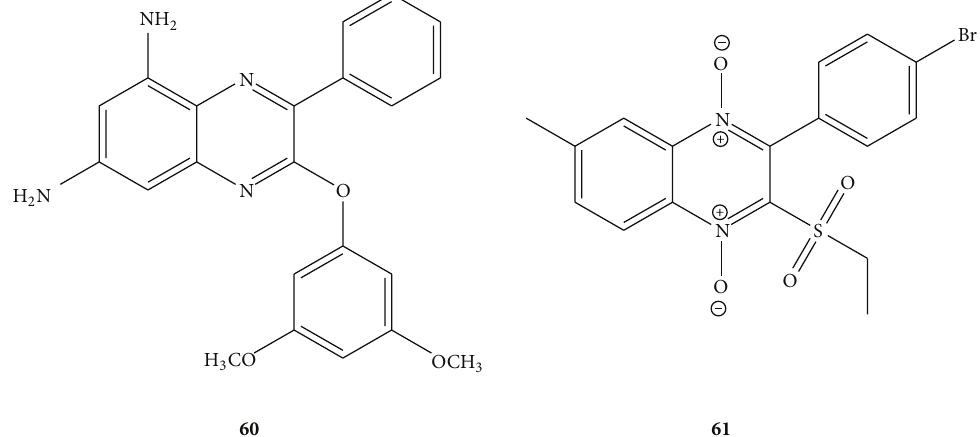
Figure 25: Chemical structures of compounds 60 and 61 .